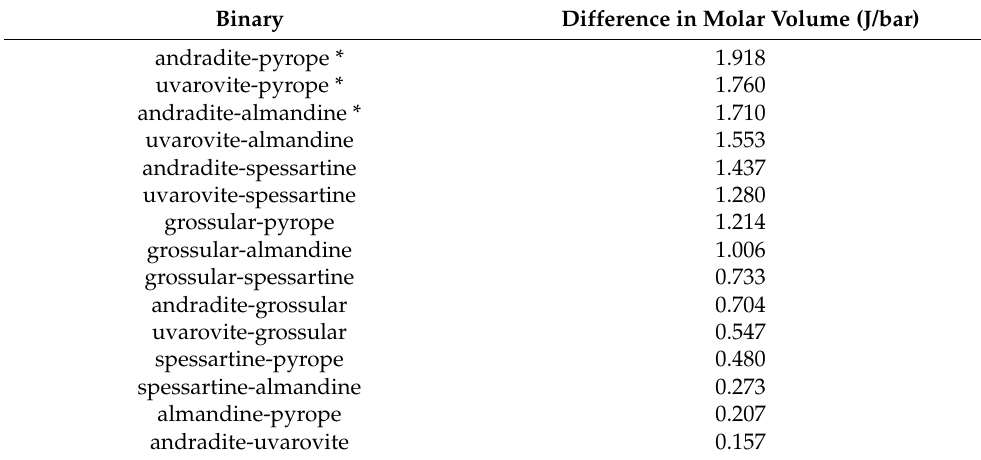
Table 2. Difference in molar volume between major end-members in